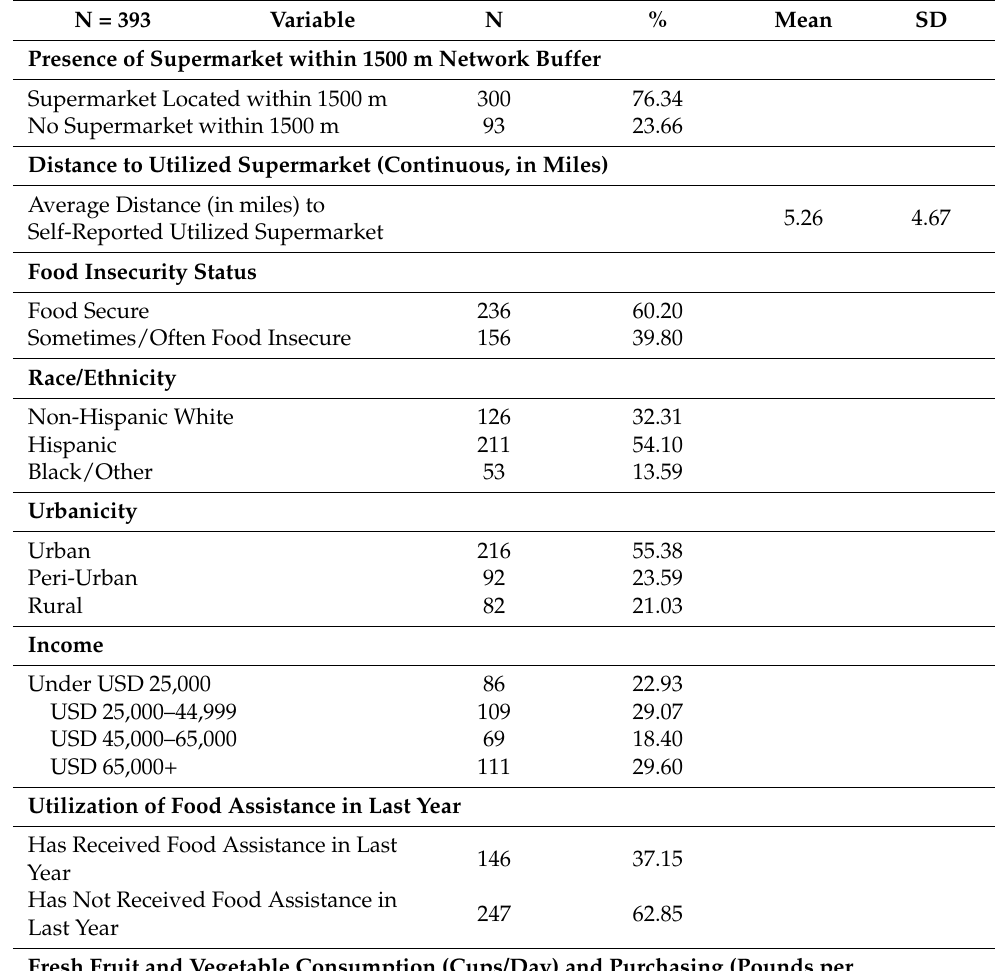
Table 1. Description of